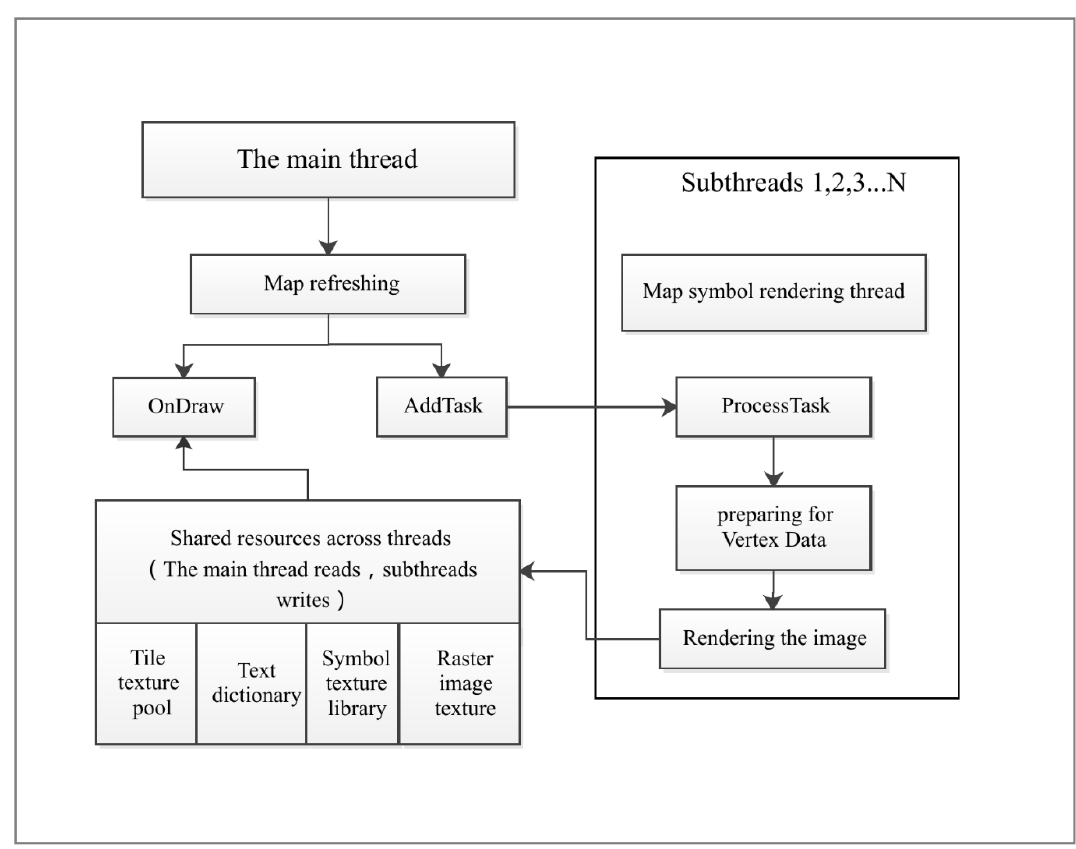
Figure 3. AR map symbol rendering parallelization frameworks in multi-core environments.